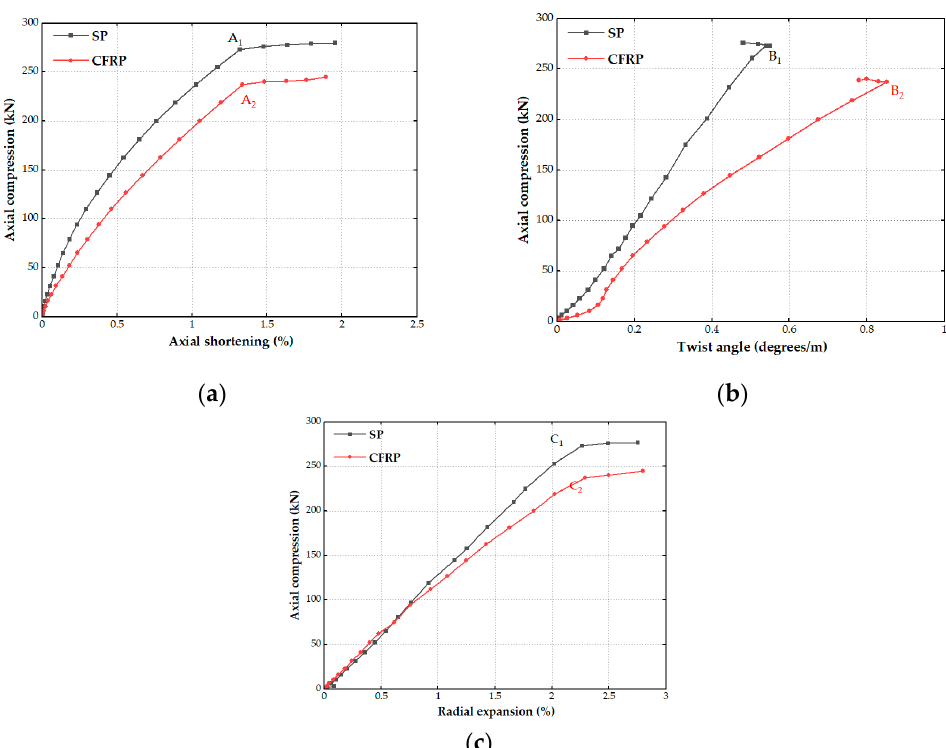
Figure 13. Axial compression response: ( a ) axial compression-shortening curves of the CFRP and